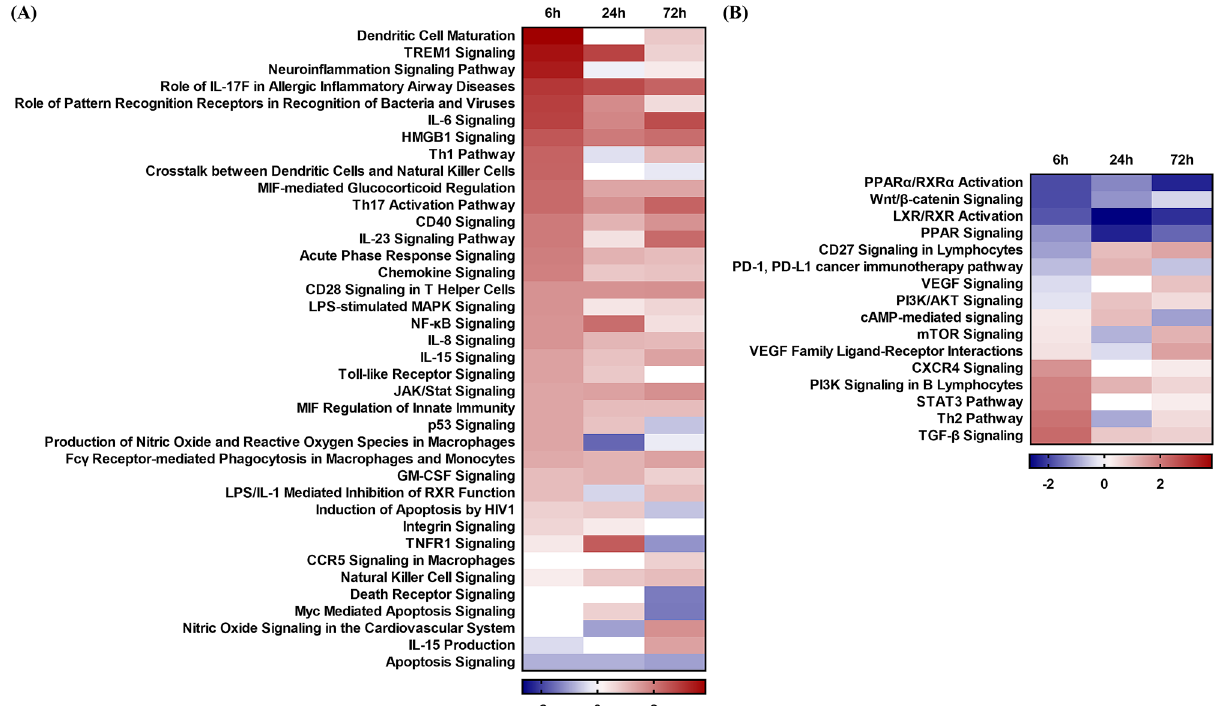
Figure 1. Heatmap of the canonical pathways related to macrophage activation in canine MDMs infected with M. intracellulare . The heatmap displays the canonical pathways related to ( A ) M1 macrophage and ( B ) M2 macrophage polarization. The color gradient reflects the predicted directions based on the z-score, where blue represents inhibition and red represents